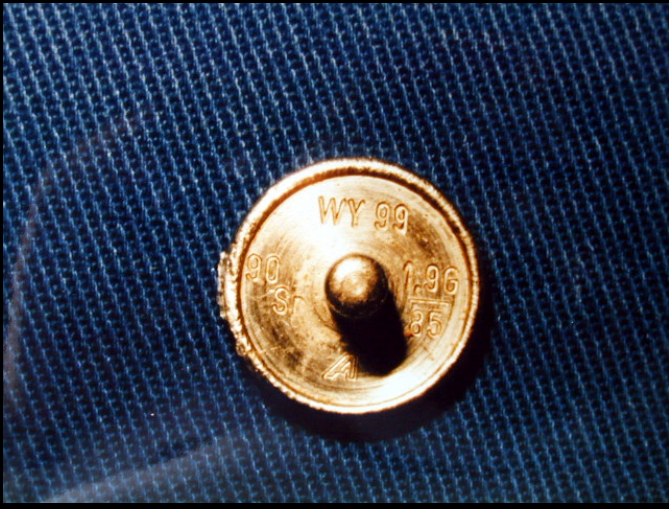
FIGURE 4 – Photograph showing the Strontium-90 plate used to emit beta